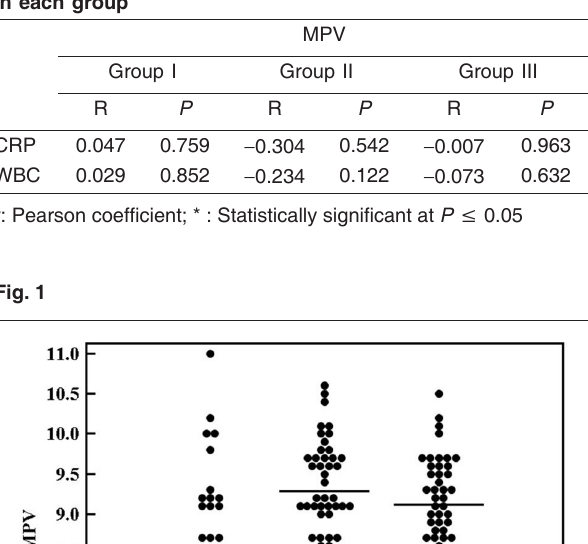
Table 2: Correlation between MPV and both CRP and WBCs in each